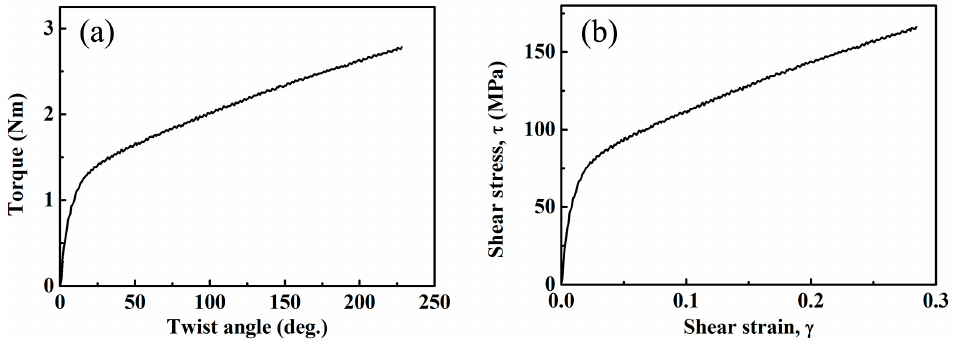
Figure 1. ( a ) Measured twist angle vs. torque curve of AZ91 during free end torsion at room temperature and ( b ) shear stress vs. shear strain curve obtained from the measured twist angle vs. torque curve.